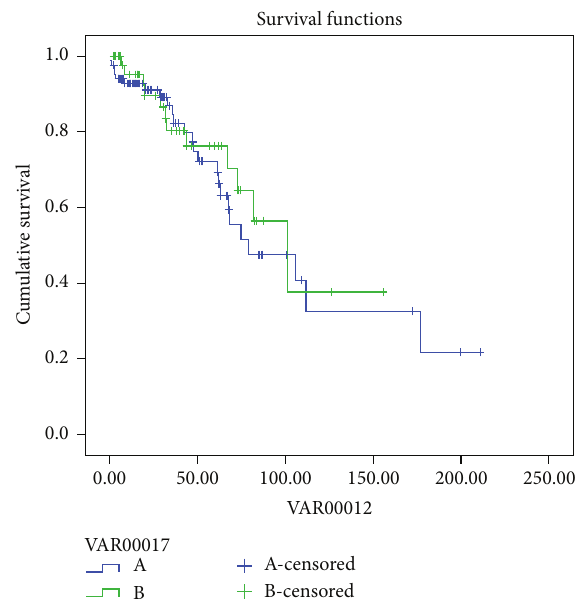
Figure 5: Catheters survival PDF (green) and HDPD (blue) (log rank 𝑃 = 0.62 ).